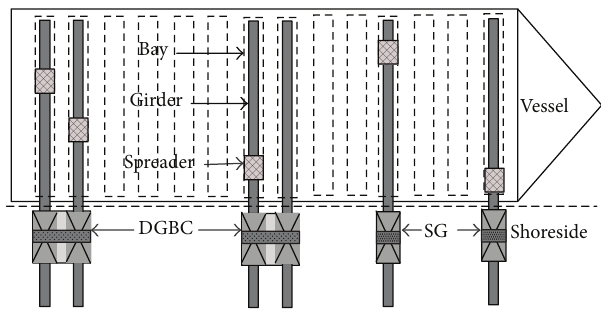
Figure 1: Comparing DGBC with